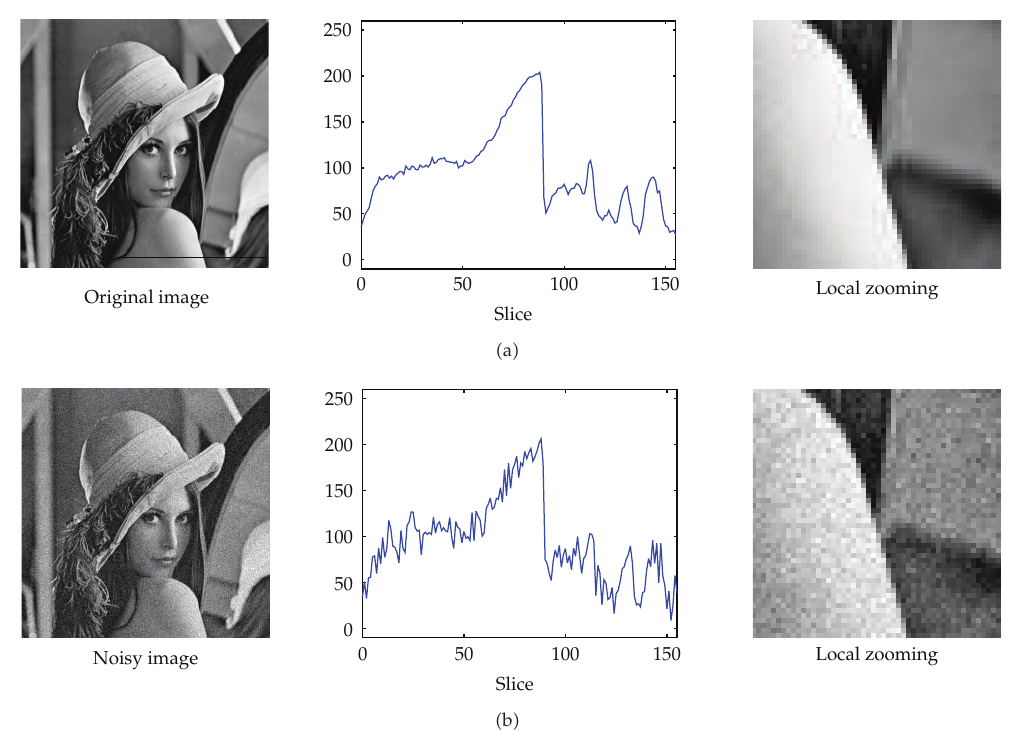
Figure 2: The original and the noisy image in Example